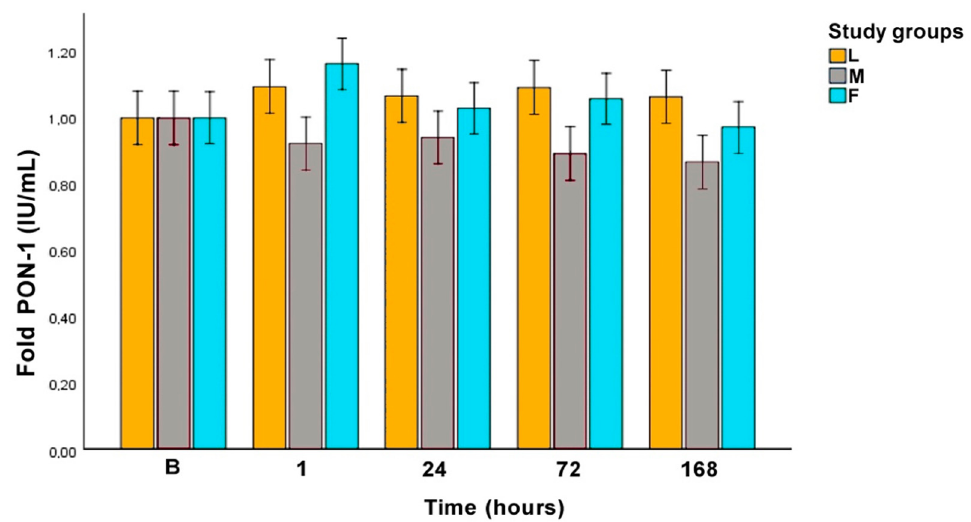
Figure 5. Fold paraoxonase-1 (PON-1) concentration along the experimental period. L: laparoscopic OVE, M: midline OVE, and F: flank OVE. B: baseline.